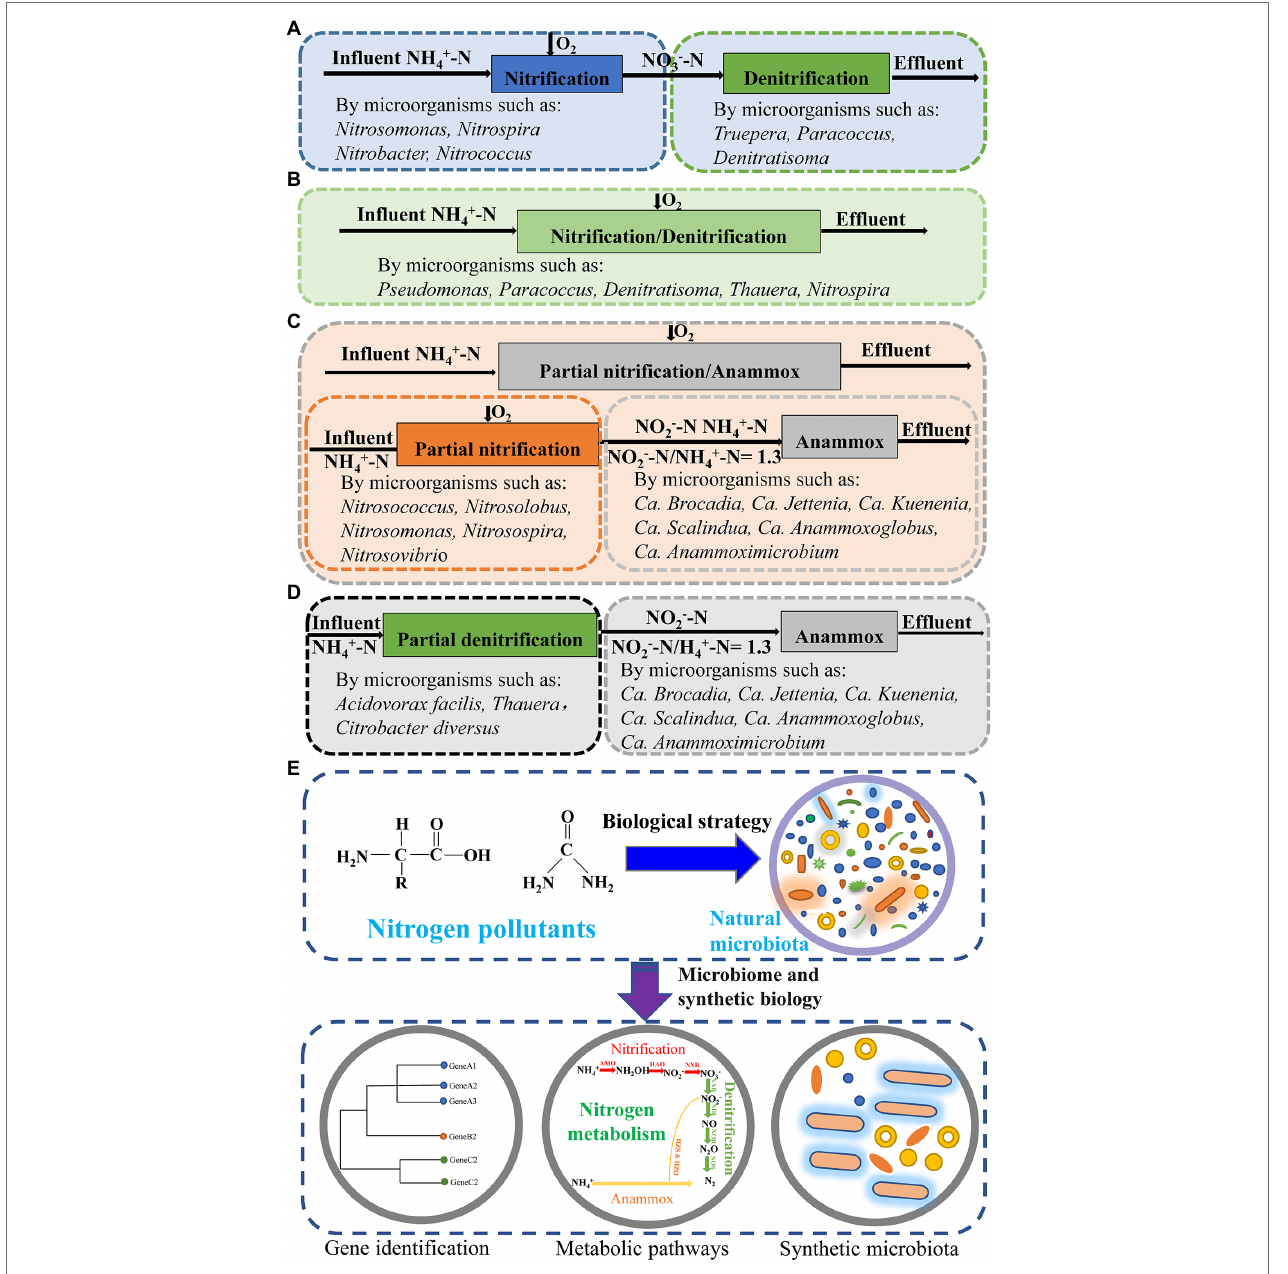
FIGURE 1 | Biological nitrogen removal processes and the microorganisms involved in these processes. (A) Traditional nitrification and denitrification processes. (B) Simultaneous nitrification-denitrification process. (C) Partial nitrification-anammox process. (D) Partial denitrification-anammox process. (E) Microbiome and synthetic biology strategy used for nitrogen pollutant removal process. The natural microbiota is used for nitrogen pollutant removal; with the help of microbiome and synthetic biology strategy, new nitrogen removal strains can be isolated and engineered strains can be constructed; and these strains can be engineered for synthetic microbiota with efficient nitrogen removal